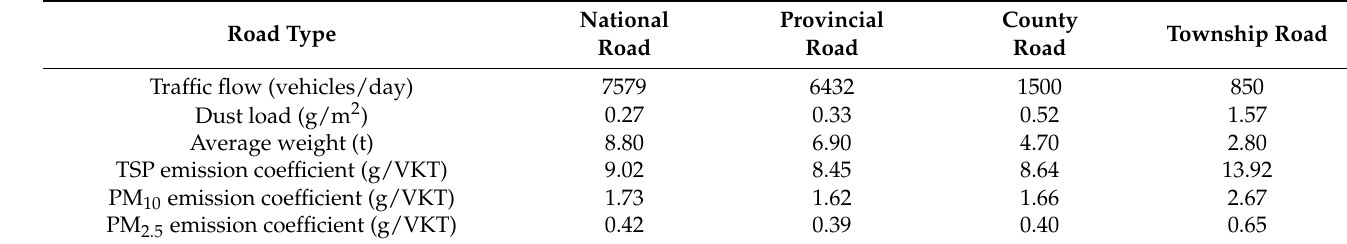
Table 1. Emission parameters of different levels of paved